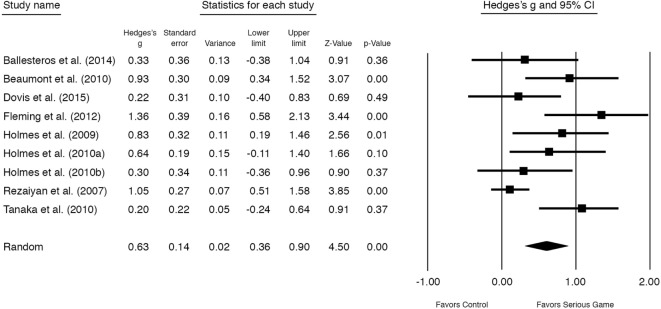
Standardized effect sizes of serious gaming interventions for mental health compared with control group. Note: study with treatment as usual as control group removed from analysis.